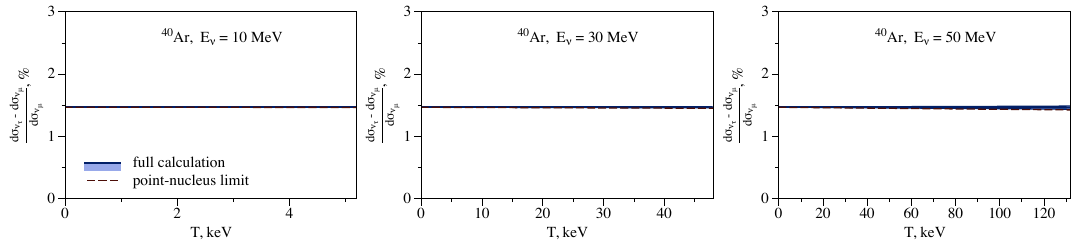
(cid:0) d (cid:1) . The Q 2 dependence in kinematics σ ν − d σ ν / d σ ν τ µ µ